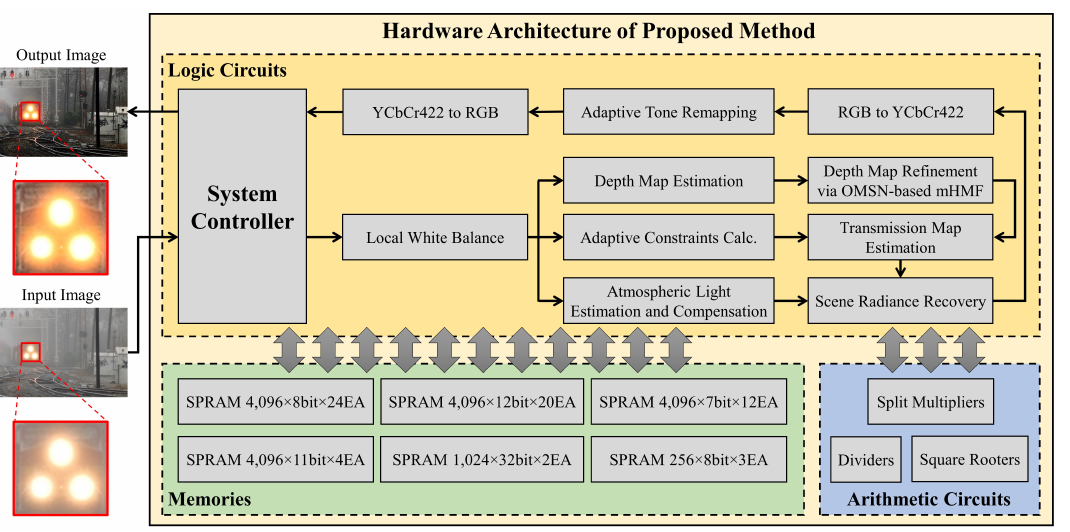
Figure 14. Overall architecture of the hardware accelerator for the proposed